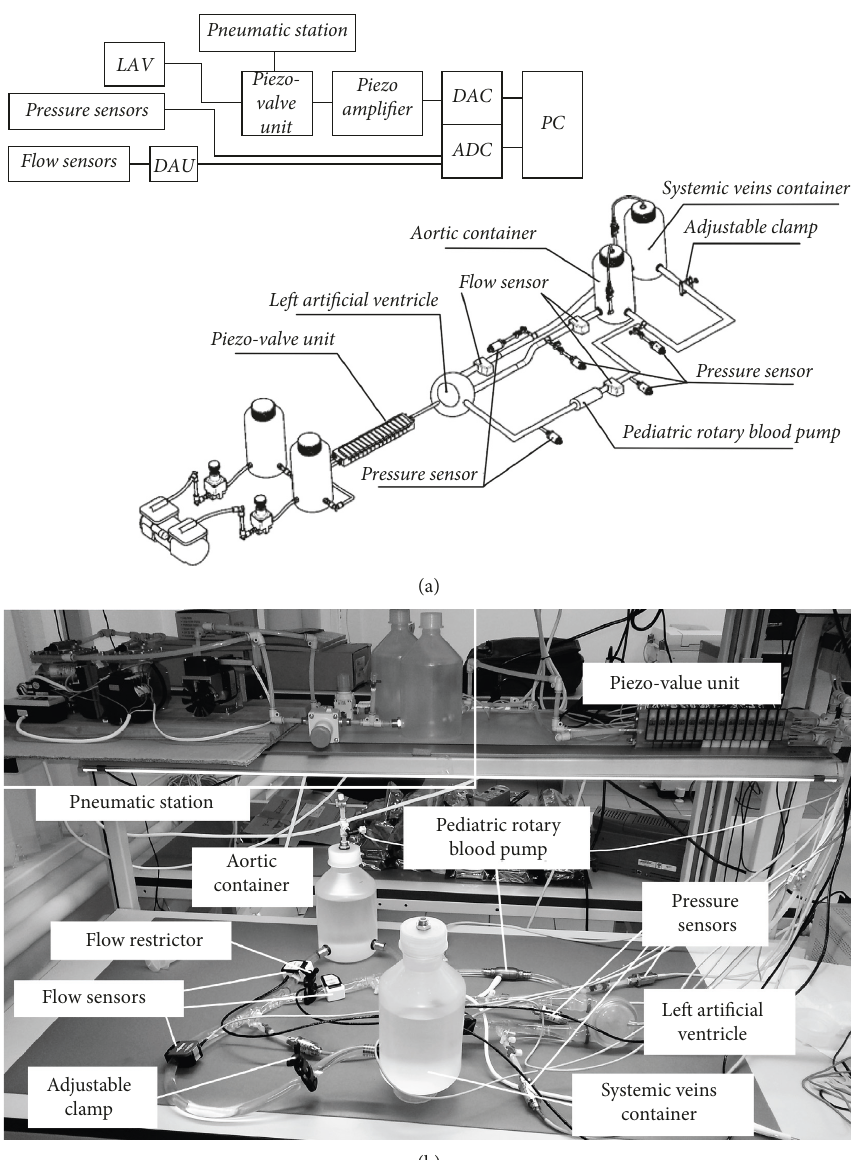
Figure 4: (a) Schematics of PMC showing main functional hardware blocks. LAV, left artificial ventricle; DAU, data acquisition unit; ADC, analog-to-digital converter; DAC, digital-to-analog converter; PC, personal computer. (b) Image of the pediatric mock circulation (PMC) simulating the acute heart failure with the Sputnik PRBP support. The flow direction is shown via an